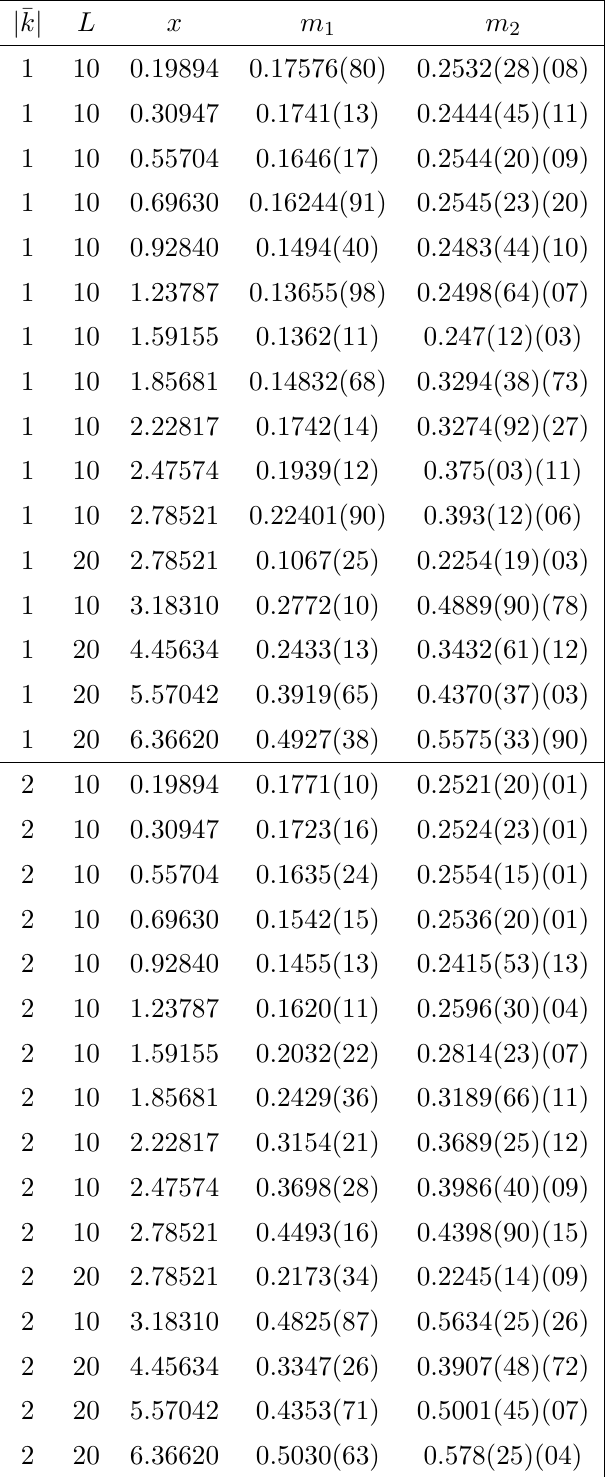
Table 19. Mass gap and next excited state energy (in lattice units) in the zero-electric (cid:13)ux scalar sector for SU(7).